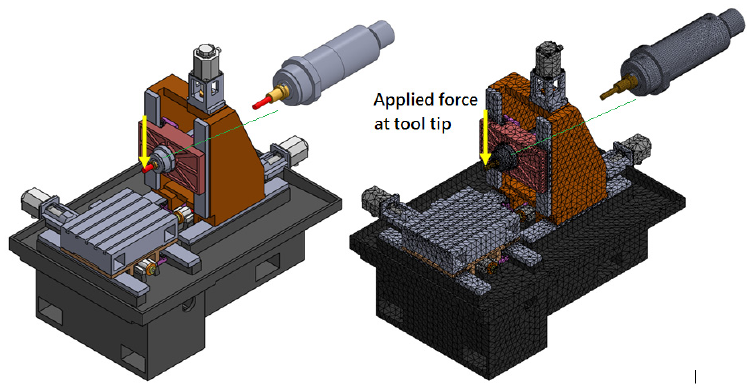
Figure 4. Finite element models of the milling machine.